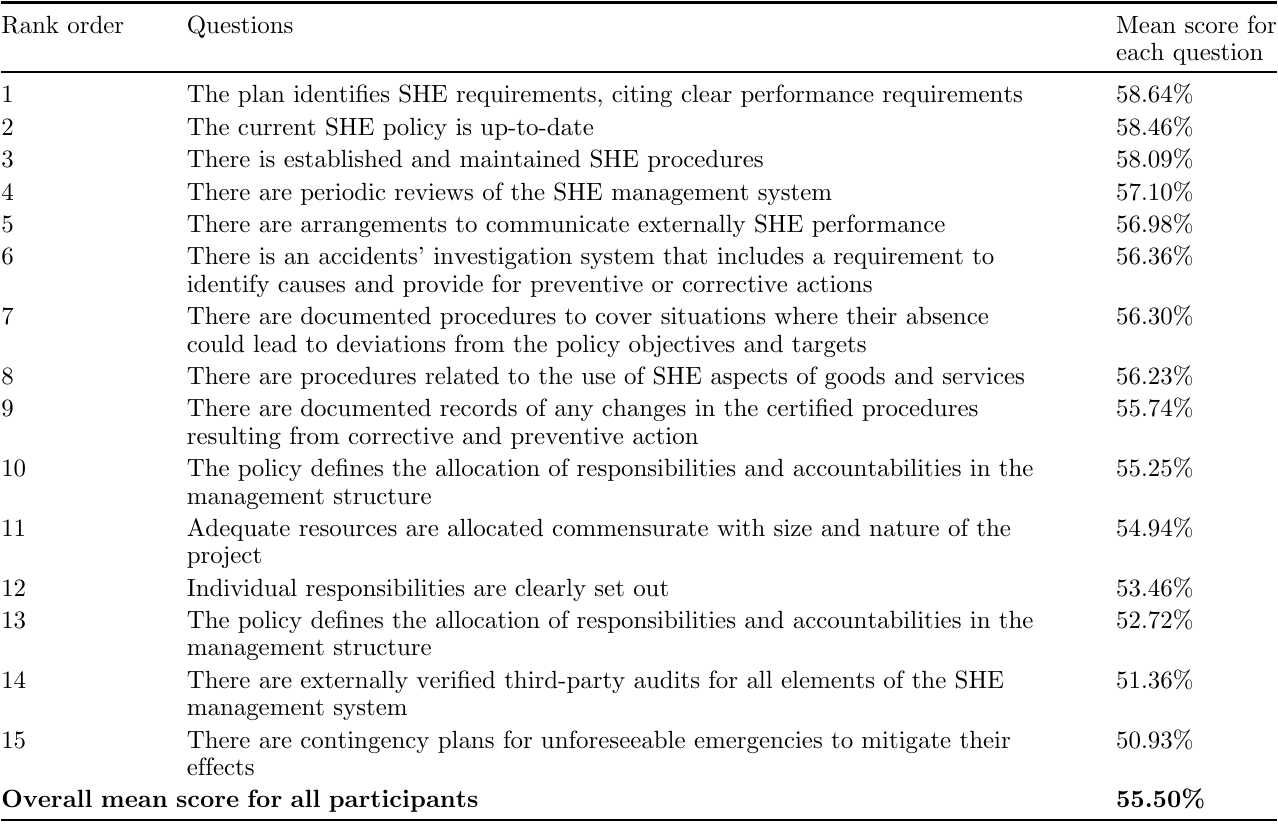
Table 2. 15 statements to which respondents indicated the extent to which they agreed or disagreed: environmental and H&S activities are appropriately integrated (Variable of